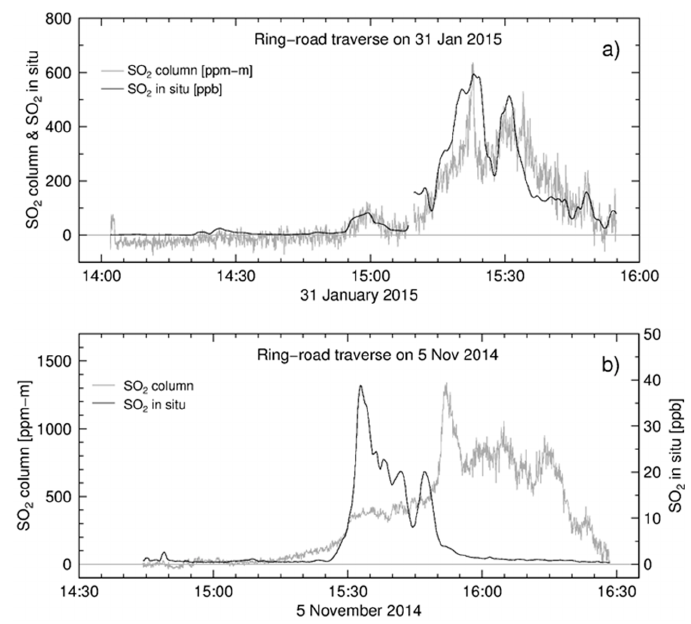
Figure 7. Examples of ring-road traverses with concurrent MobileDOAS SO 2 column and in situ SO 2 measurements. ( a ) 31/01/15 with peaks corresponding very closely and ( b ) 05/11/14 with incongruent peaks.